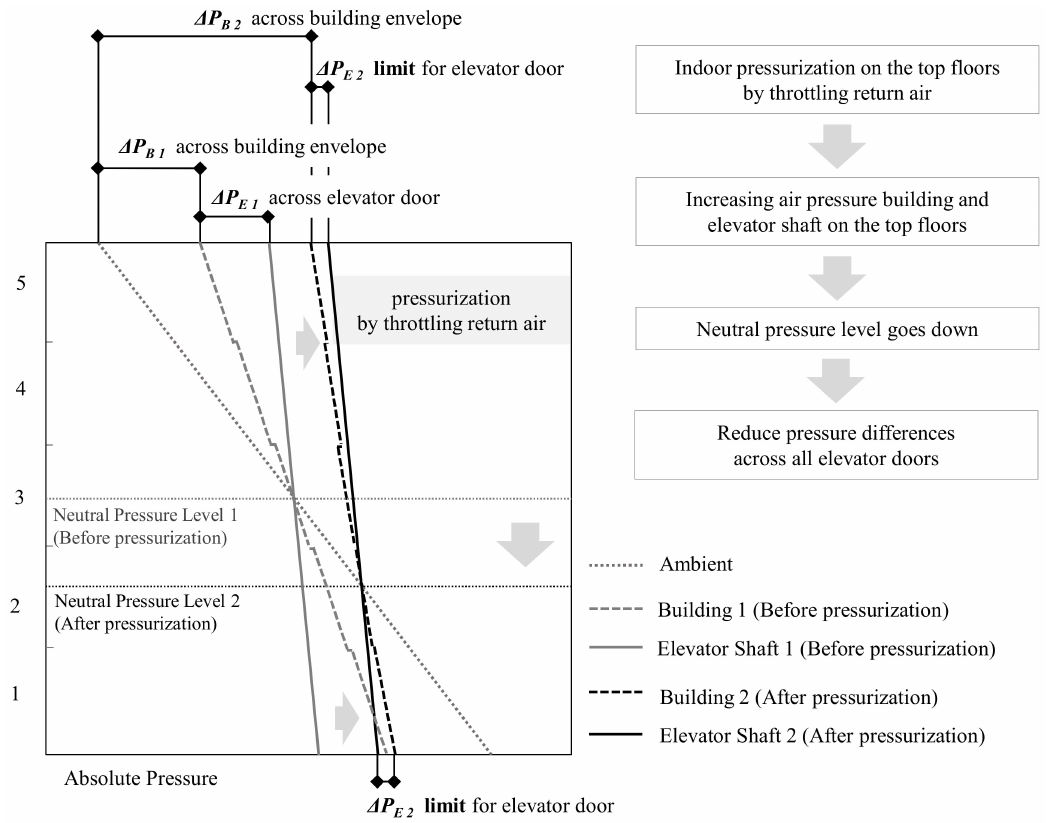
Figure 2. Absolute pressure changes when pressurizing high-rise zone by reducing return air